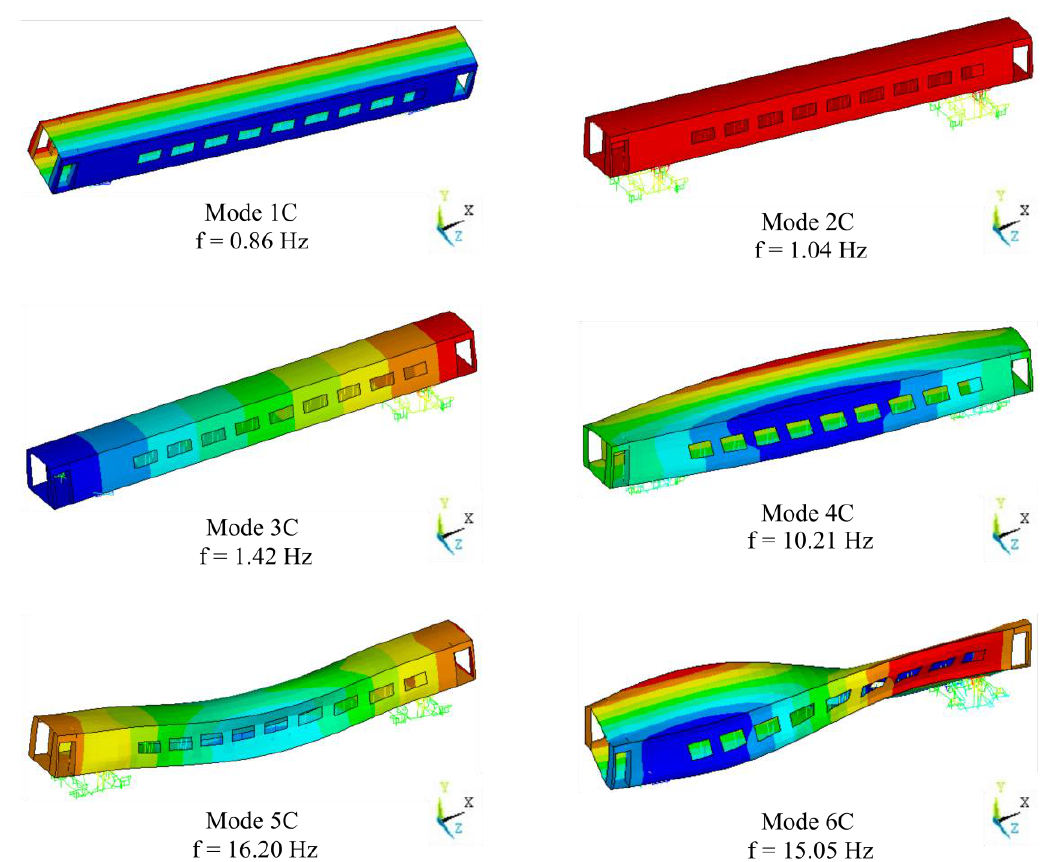
Figure 4. Numerical modes of the BBN vehicle ’s carbody.